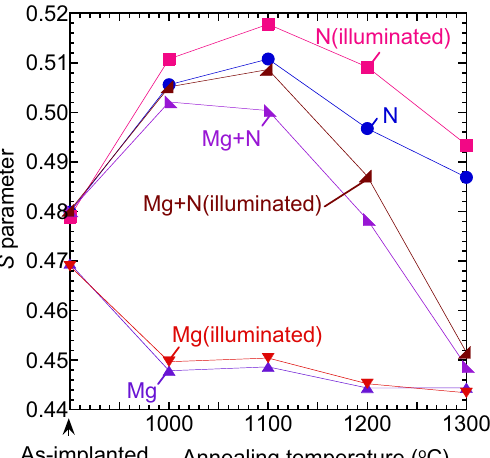
Figure 4. Annealing behaviors of S for Mg- and N-implanted GaN. Result for Mg-implanted GaN with N-implantation is also shown. S values were measured by using coincidence system in darkness and under illumination.